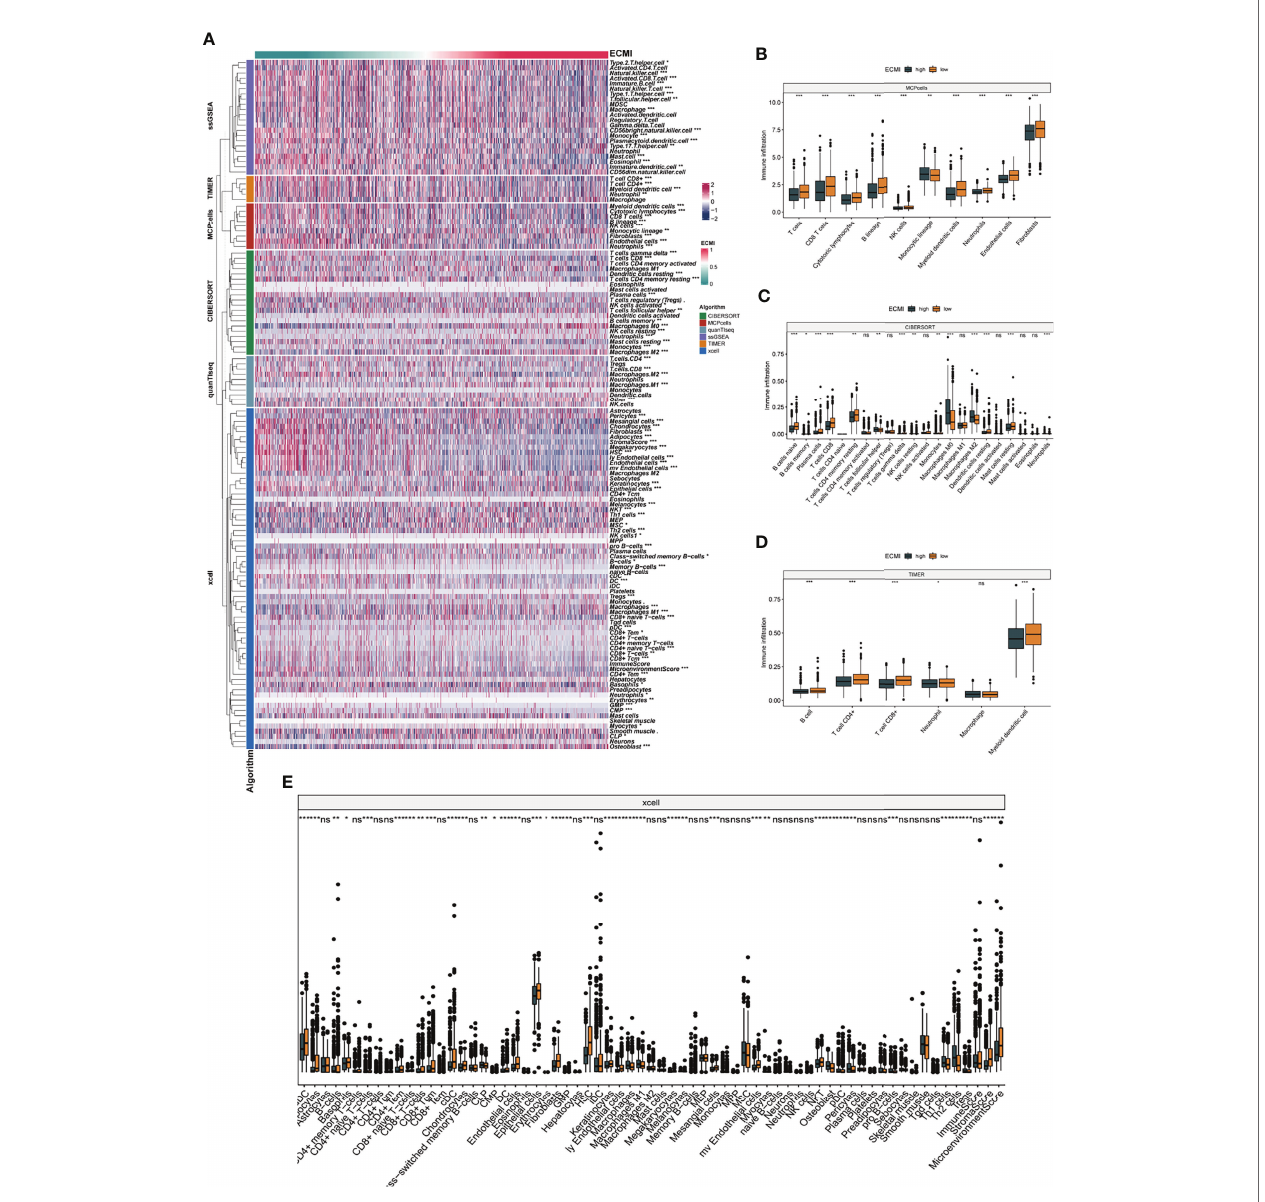
FIGURE 5 | The landscape of immune in fi ltration based on the ECMI. (A) Heatmap for the in fi ltration of immune cells with row representing different kinds of immune cells and column representing different samples with the ECMI increasing from left to right. (B – E) Box plots showing the immune in fi ltration levels in ECM high and ECMI low based on MCPcells, CIBERSORT, TIMER, and xCell algorithm. *p < 0.05, ***p < 0.001, ****p < 0.0001. ns, not statistically signi fi